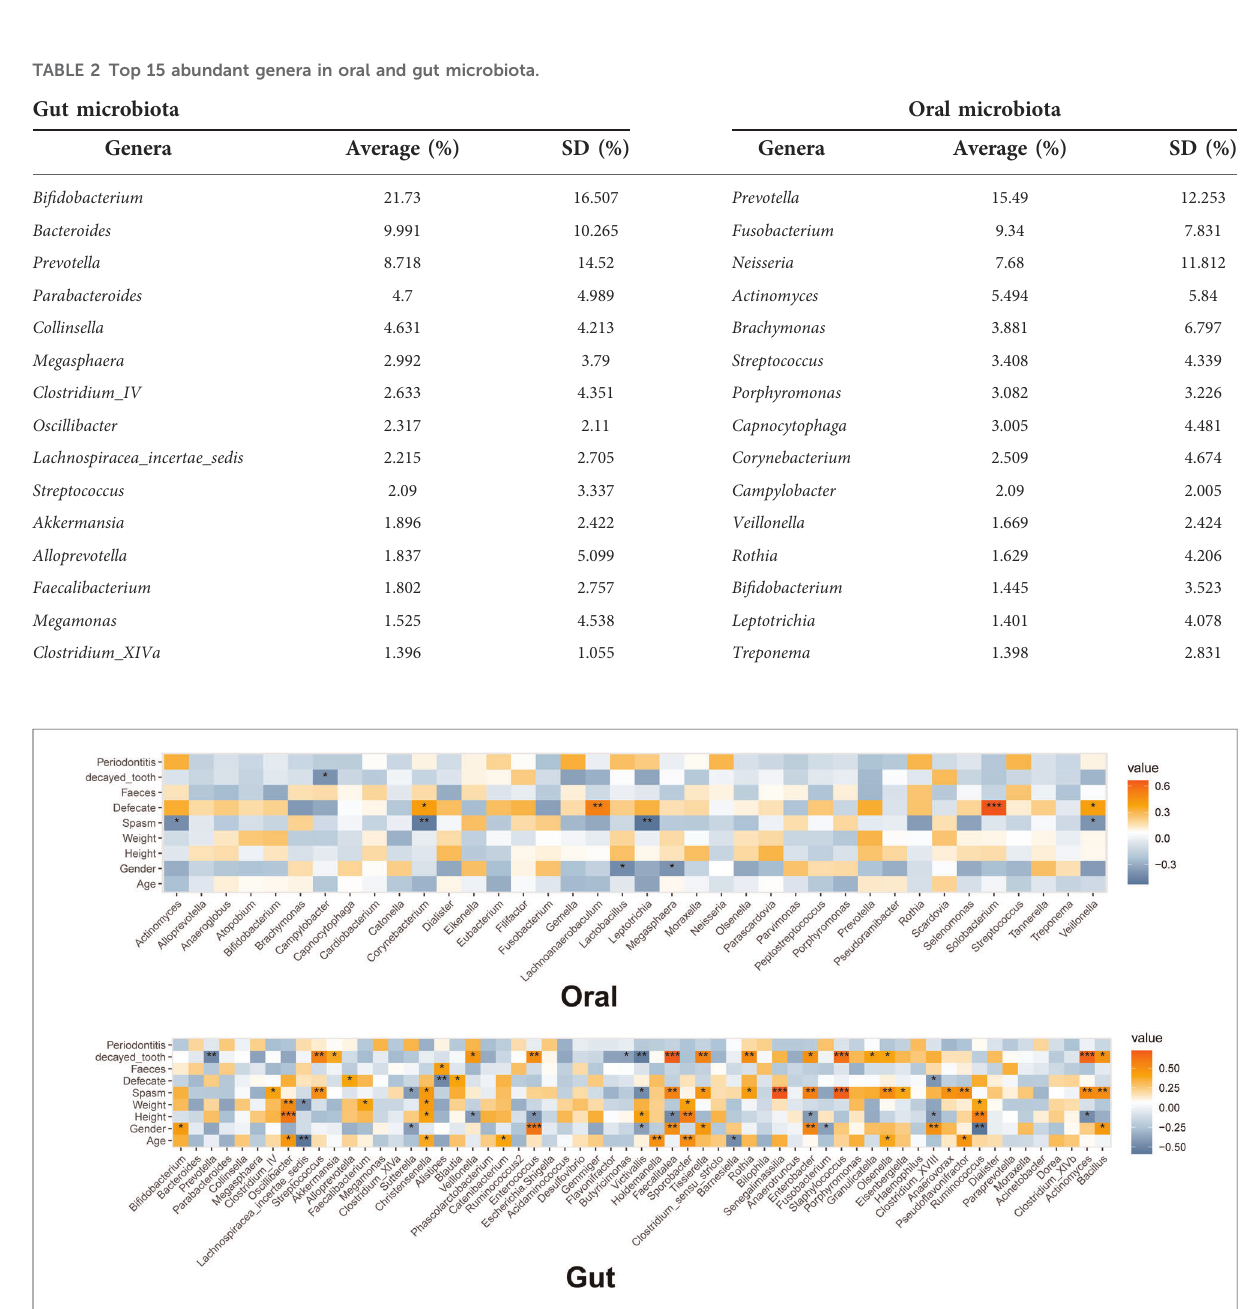
FIGURE 1 Heatmap for the association of microbiota with clinical phenotypes. The color represents the correlation coef fi cient: green, negative correlation; red, positive correlation. The asterisk represents the signi fi cance of correlation: *, **, ***, and **** represent P =0.05, 0.01, 0.001, and 0.0001,